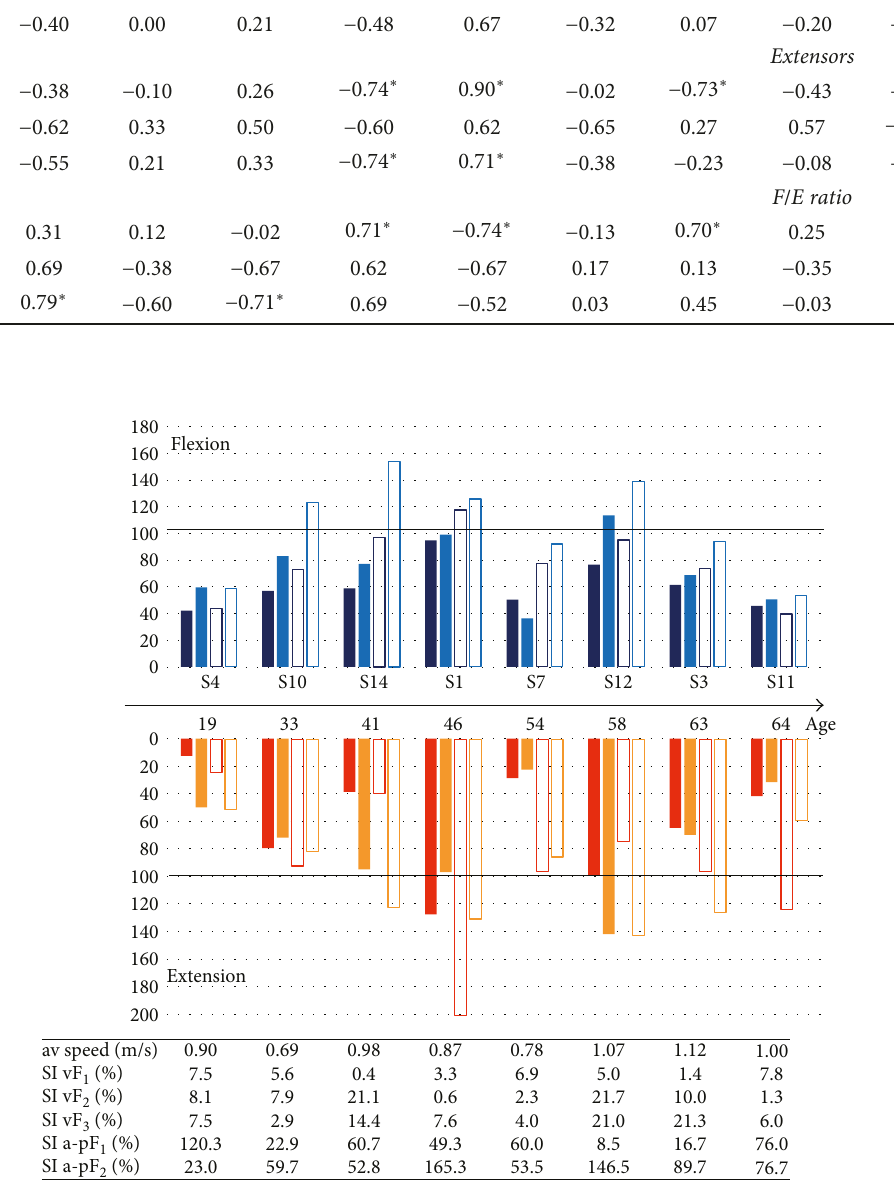
Figure 3: Individual results of the tested subjects: peak torques for fl exors and extensors, the average speed (av speed), and symmetry indexes (SI) for GRF variables. Muscle torque values of joint hip fl exors and extensors were normalized to values obtained by healthy people in their age category (continuous horizontal line). Dark blue bar denotes the values for isometric conditions and light blue for the isokinetic 60deg/s conditions for amputated ( fi lled) and intact limb (no fi